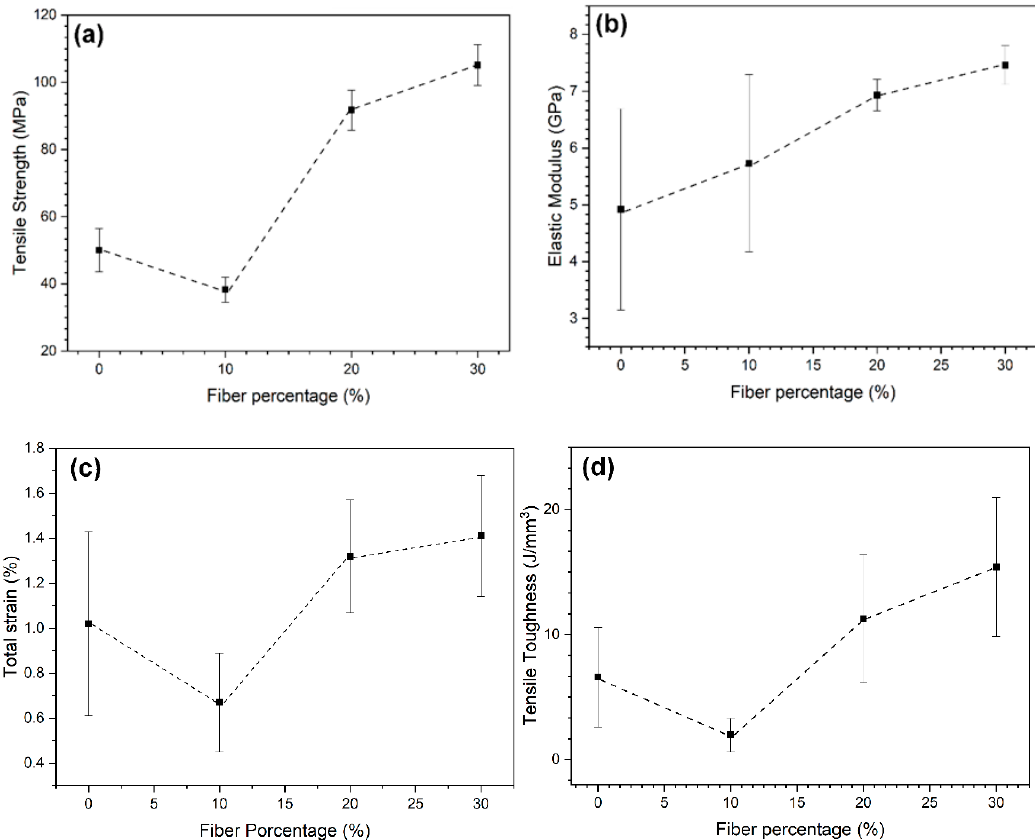
Figure 5. Variation of ( a ) tensile strength ( b ) elastic modulus ( c ) total elongation ( d ) tensile toughness